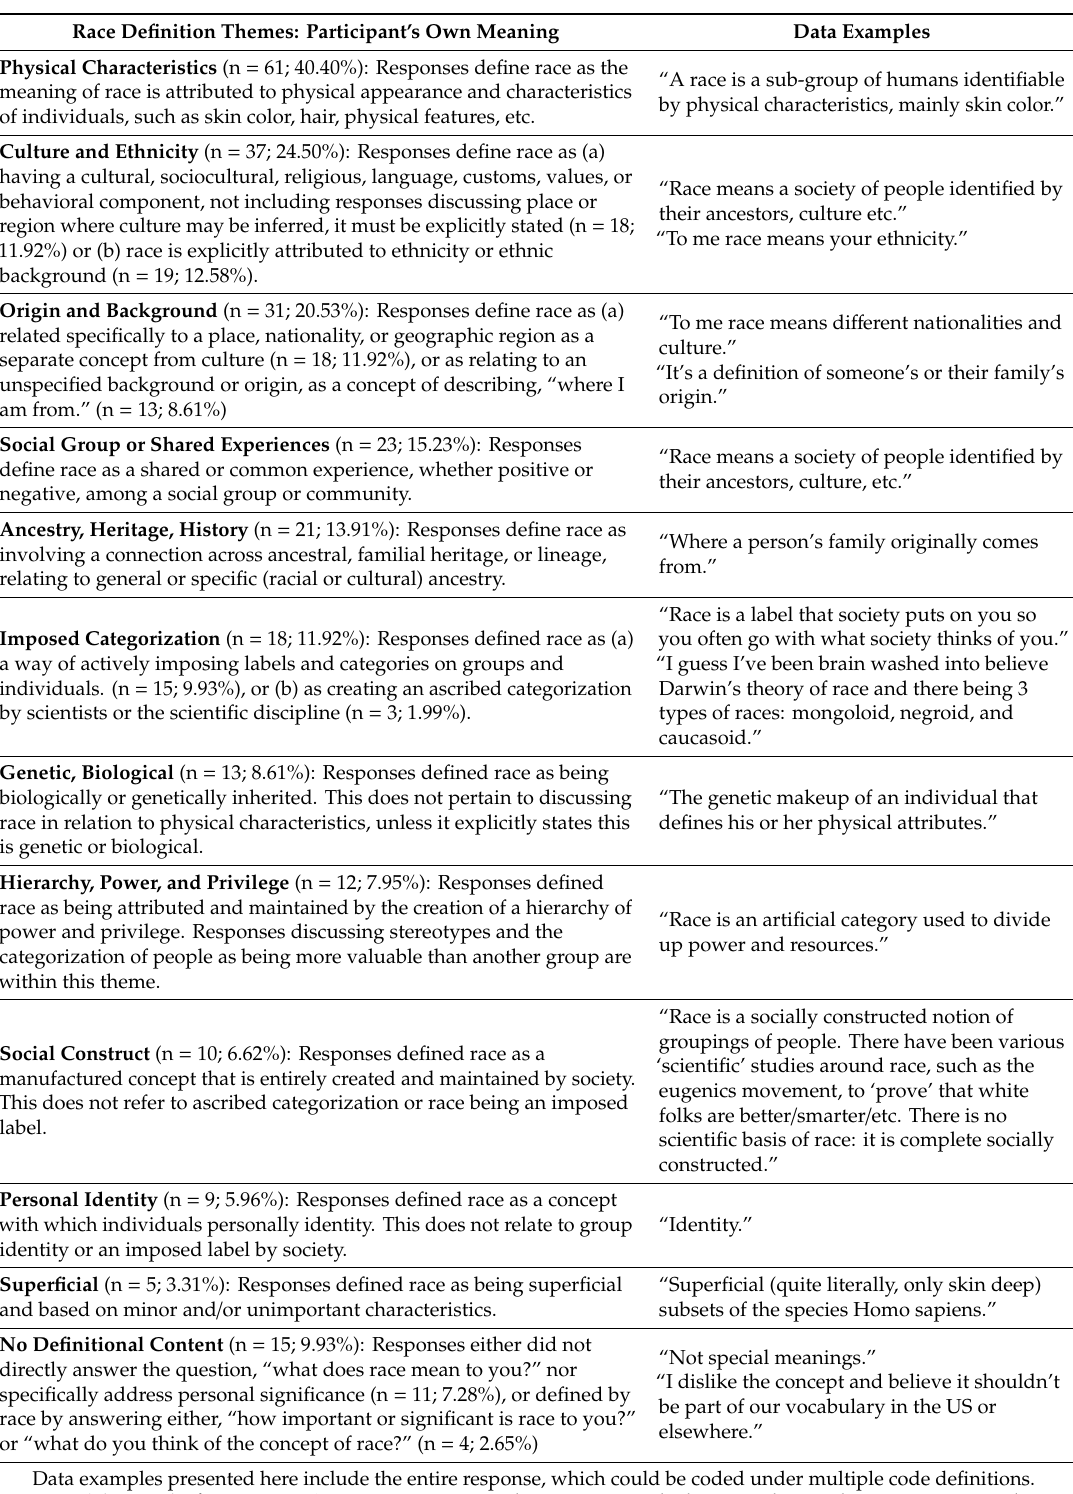
Table 2. Colloquial meanings of